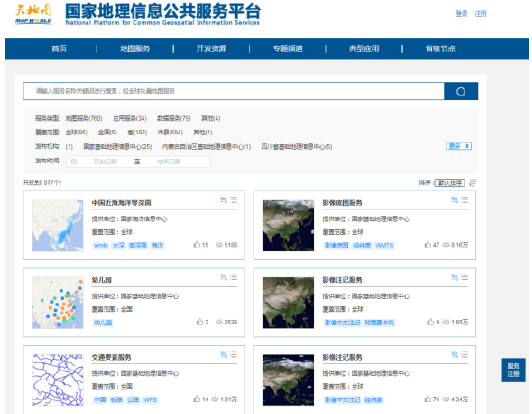
Figure 7 . The National Platform for Common Geospatial Information Services